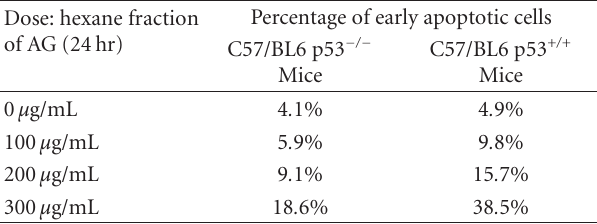
Table 1: Apoptosis (Annexin V positive; propidium iodide nega- tive) of CD4 + /CD25 − e ff ector T cells from the spleen of p53 − / − mice